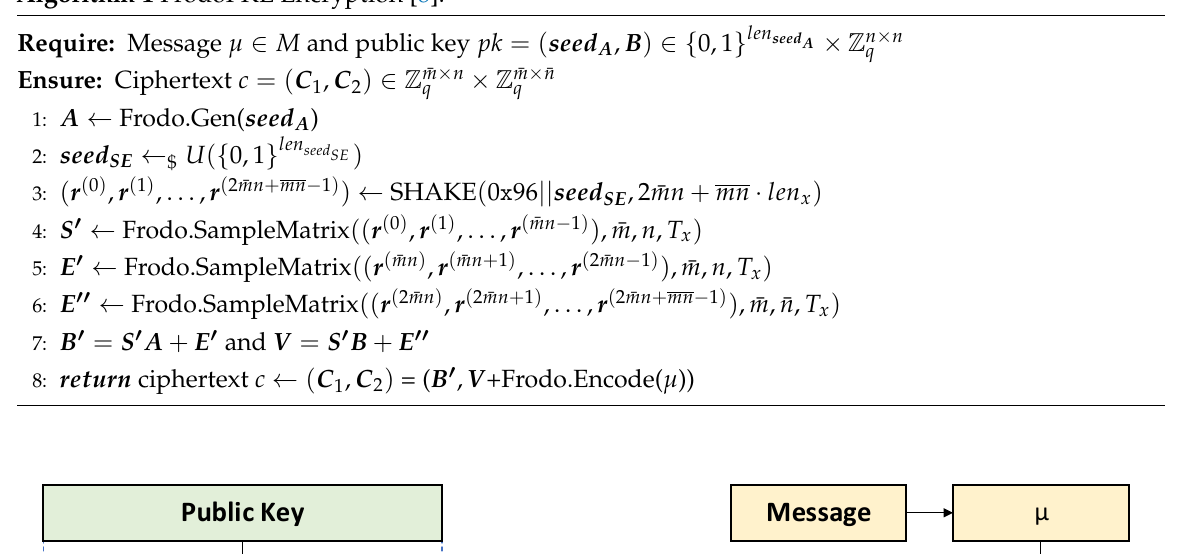
Algorithm 1 FrodoPKE Encryption [8].